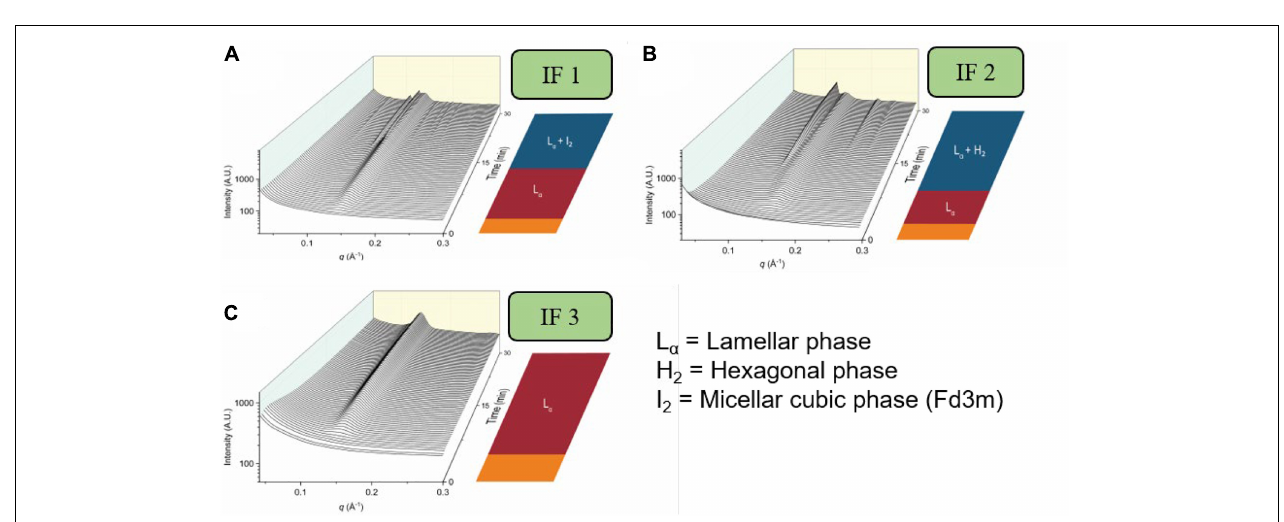
FIGURE 12 | The formation of mesophases during the digestion of mammalian milk. Scattering profiles of (A) bovine milk, (B) goat milk, and (C) human milk during in vitro digestion coupled to SAXS are shown. Adapted and reproduced from Pham et al. (2020).